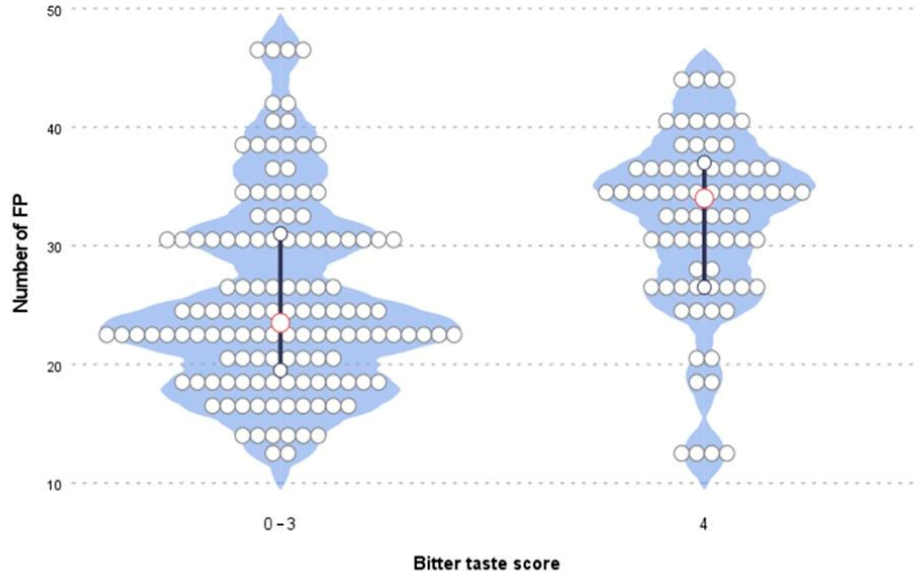
Figure 3. The distribution of the numbers of FP in categories of the bitter taste sensitivity. Spearman correlation analysis also revealed a weak association between the taste sensitivity to all tastes and the FP number ( r = 0.30, p = 0.01). There was no association between the number of FP and taste sensitivity for sweet, salty, or sour. PROP status was associated with bitter taste score and total taste score. In addition, we found a positive correlation between bitter taste score and total taste score (Table 3). Table 3. Matrix for Spearman correlation between variables: FP, PROP, all tastes, bitter taste ( n =